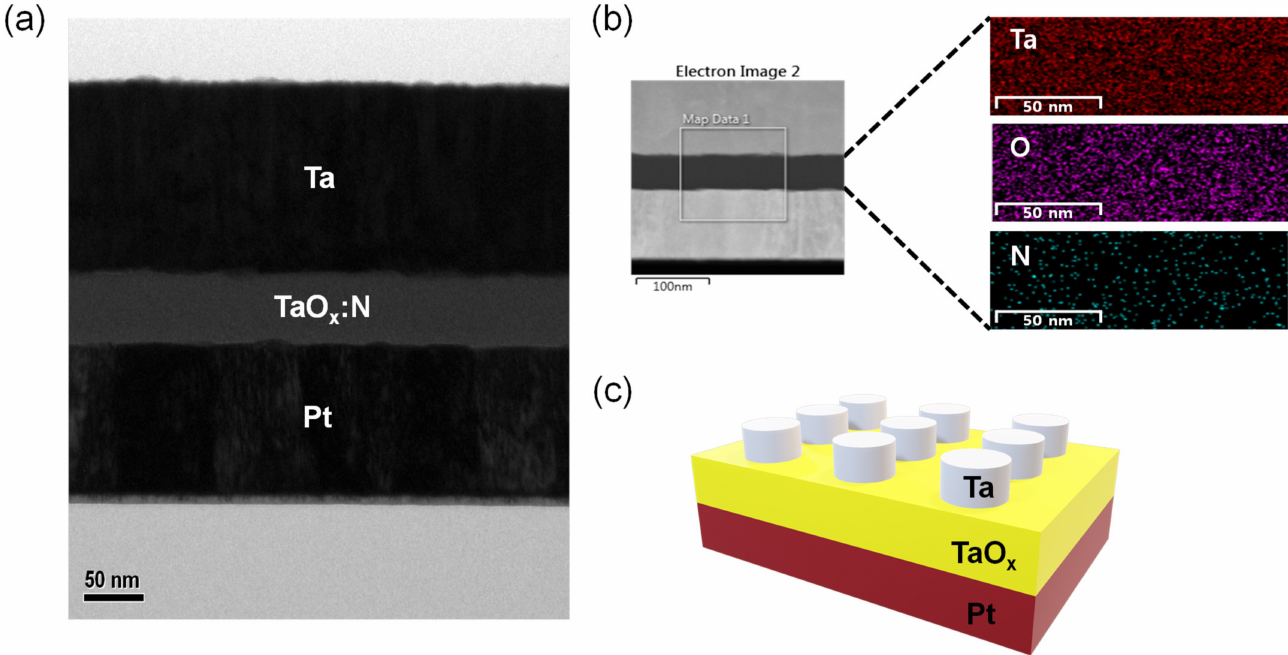
Figure 1. ( a ) High magnification imaged by TEM. ( b ) Overall image for EDS mapping. ( c ) Schematic displaying the device